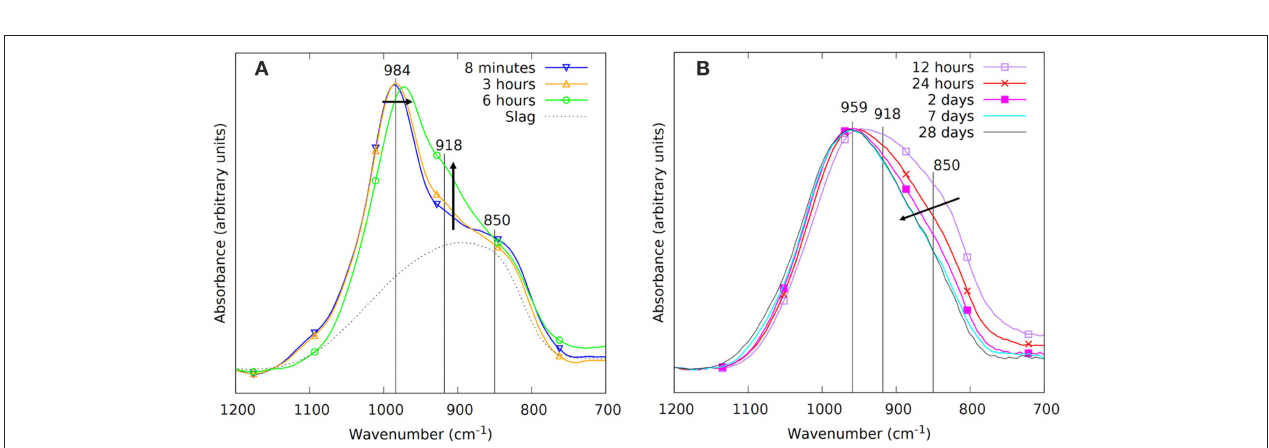
FIGURE 5 | Evolution of the absorption areas of components IP1, IP2, and the sum of absorption areas of components S1, S2, and S3. (A) Shows the short term ( ≤ 12h) evolution of the absorption areas of the IP1 and IP2 components. The IP binder components only start forming after 3h (0.125 days). (B) Shows the evolution of the absorption areas up to 28 days of curing.